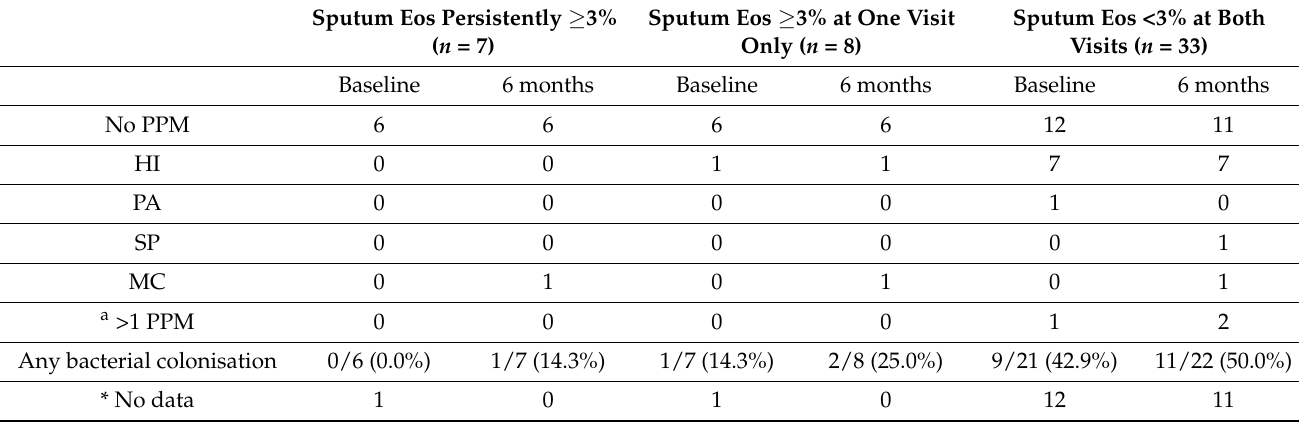
Table 2. Presence of PPMs as defined by HNS thresholds in COPD patients with sputum eosinophils persistently ≥ 3%, ≥ 3% at one visit only or <3% at both visits. n = 7, 8 and 33,